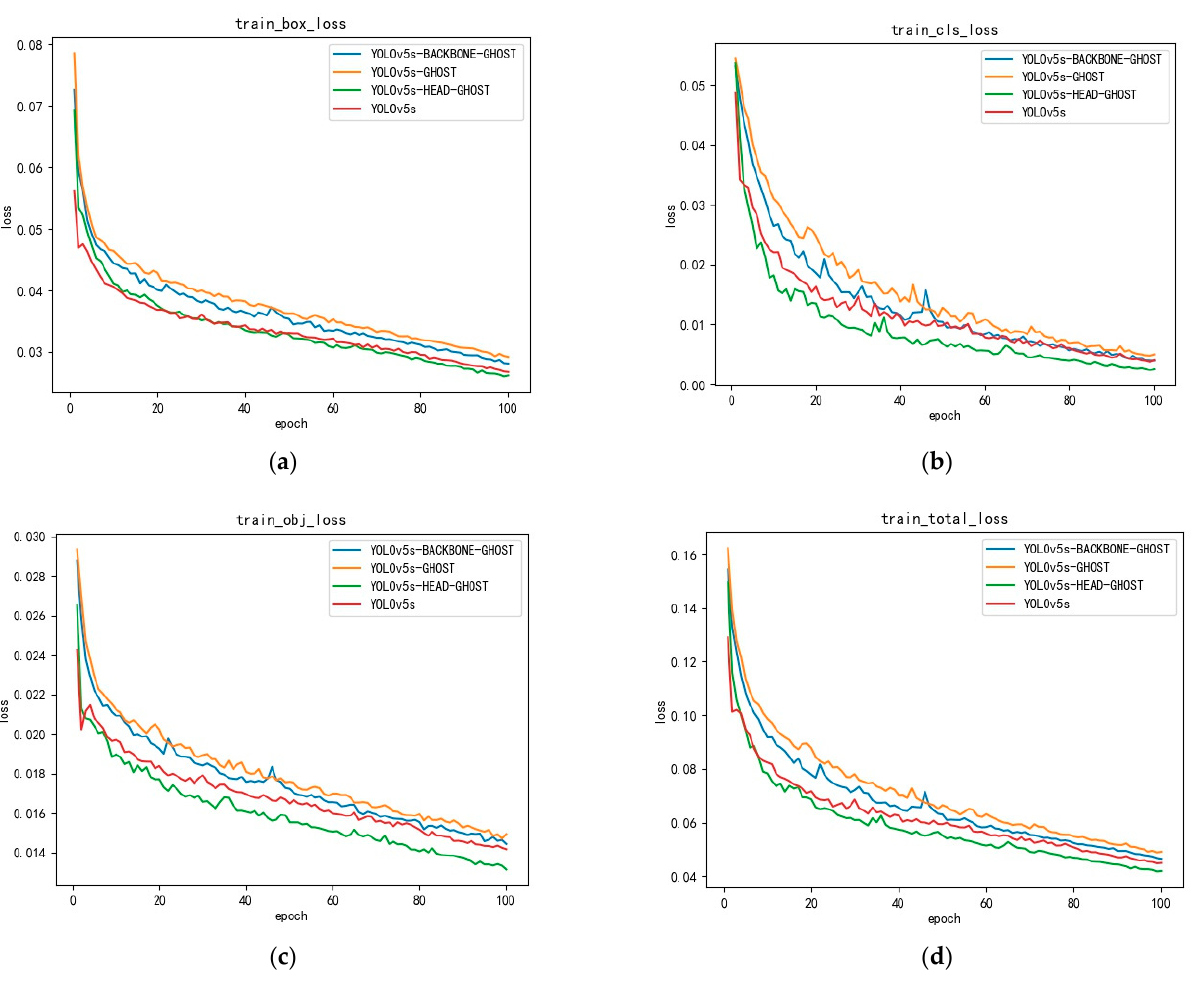
Figure 8. CIoU (Complete-IOU).